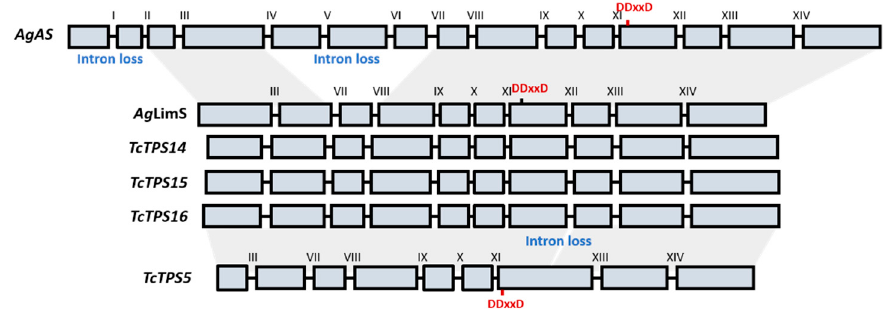
Figure 1. The proposed evolution of genome structure of conifer terpene synthase. AgAS : Abies grandis abietadiene synthase [26]; AgLimS : A. glauca limonene synthase [27]; TcTPS5 : T. cryptomerioides longifolene synthase [25]. The genome structures were illustrated based on published research [19], and the location of the active motif (DDxxD) was marked.